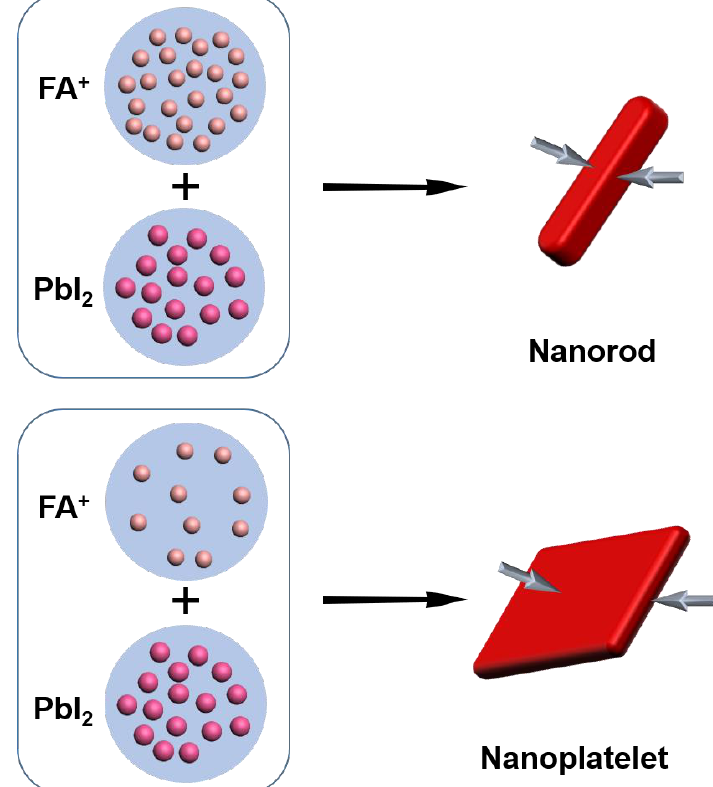
Figure 3. Schematic illustration showing the transformation of precursor-ligand complexes into either FAPbX 3 nanorods or nanoplatelets depending on FA concentration because of different surface to volume ratios.